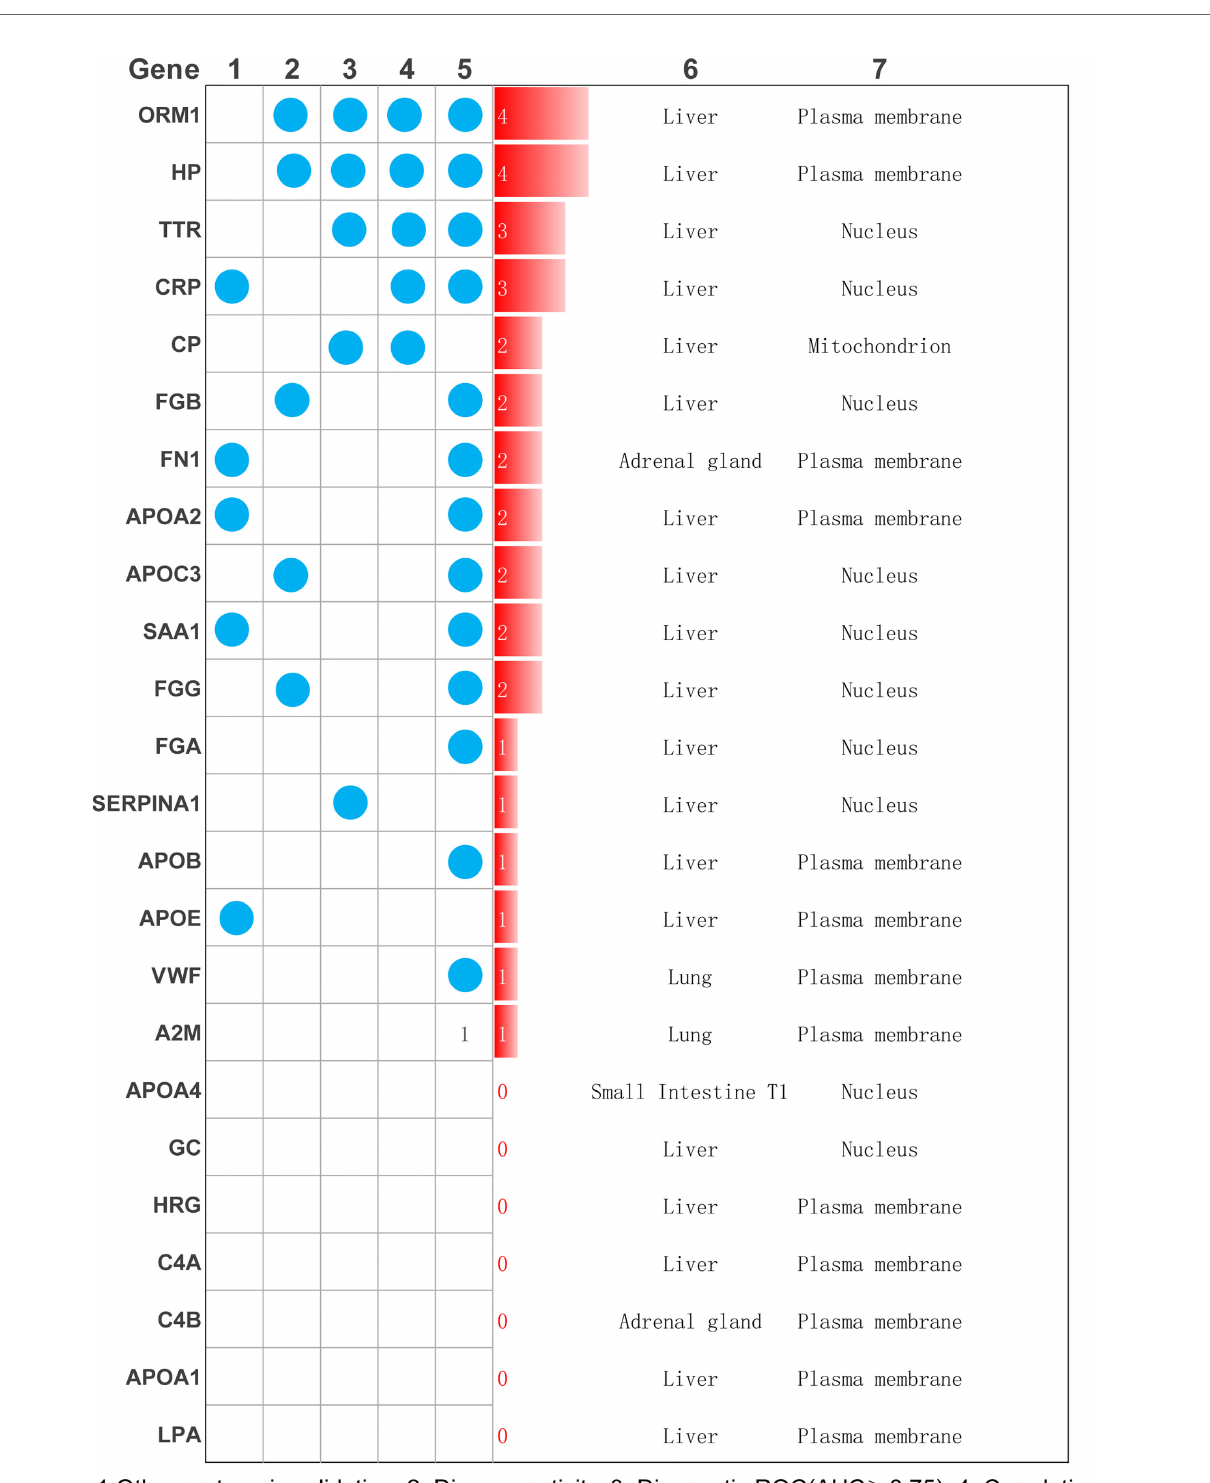
FIGURE 6 | Summarize a variety of analysis methods to select the most meaningful protein as the key protein of